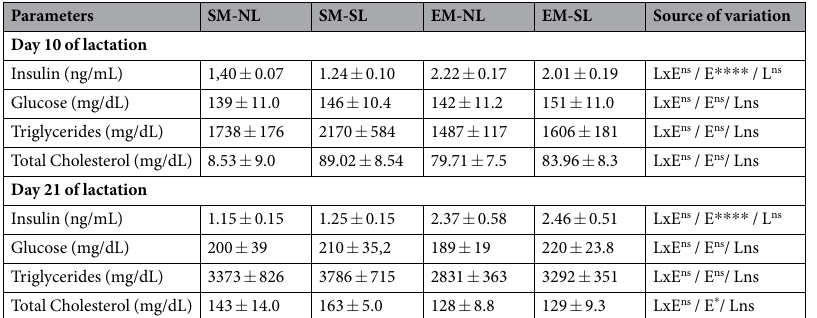
Table 2. Effect of low intensity physical exercise training on milk composition. Data are expressed as the mean ± SEM. (n = 10-12 per group). LxE, interaction between the exercise factor and the litter factor; E, exercise factor and L, litter factor; * p < 0.05 and **** p < 0.0001 and ns, no significant difference, based on a two-way analysis of variance.